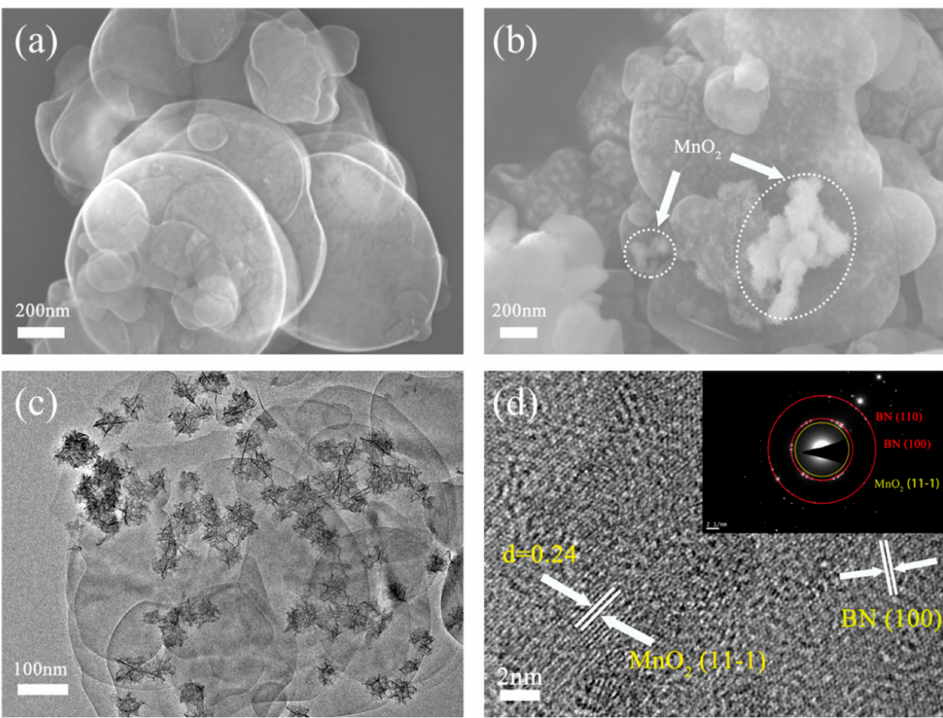
Figure 2. SEM images of BNNs ( a ) and MnO 2 @h-BNNs ( b ) and TEM images of MnO 2 @h-BNNs ( c , d